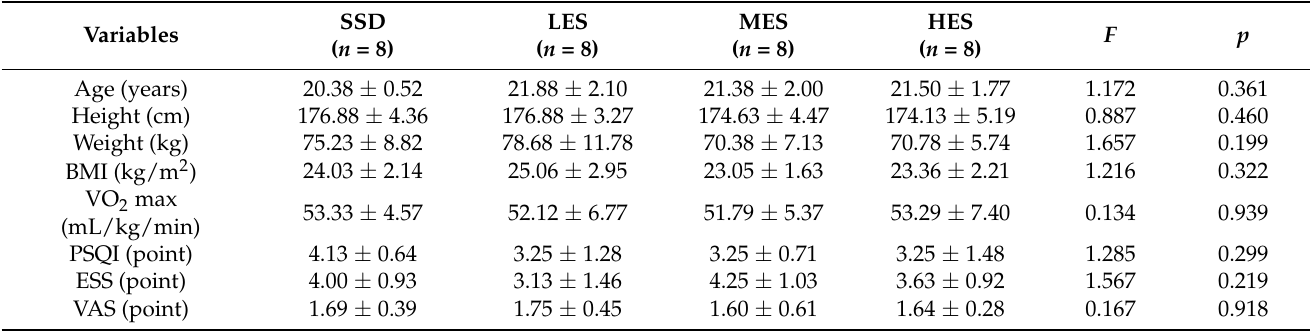
Table 1. The difference in participant baseline characteristics among treatment groups.